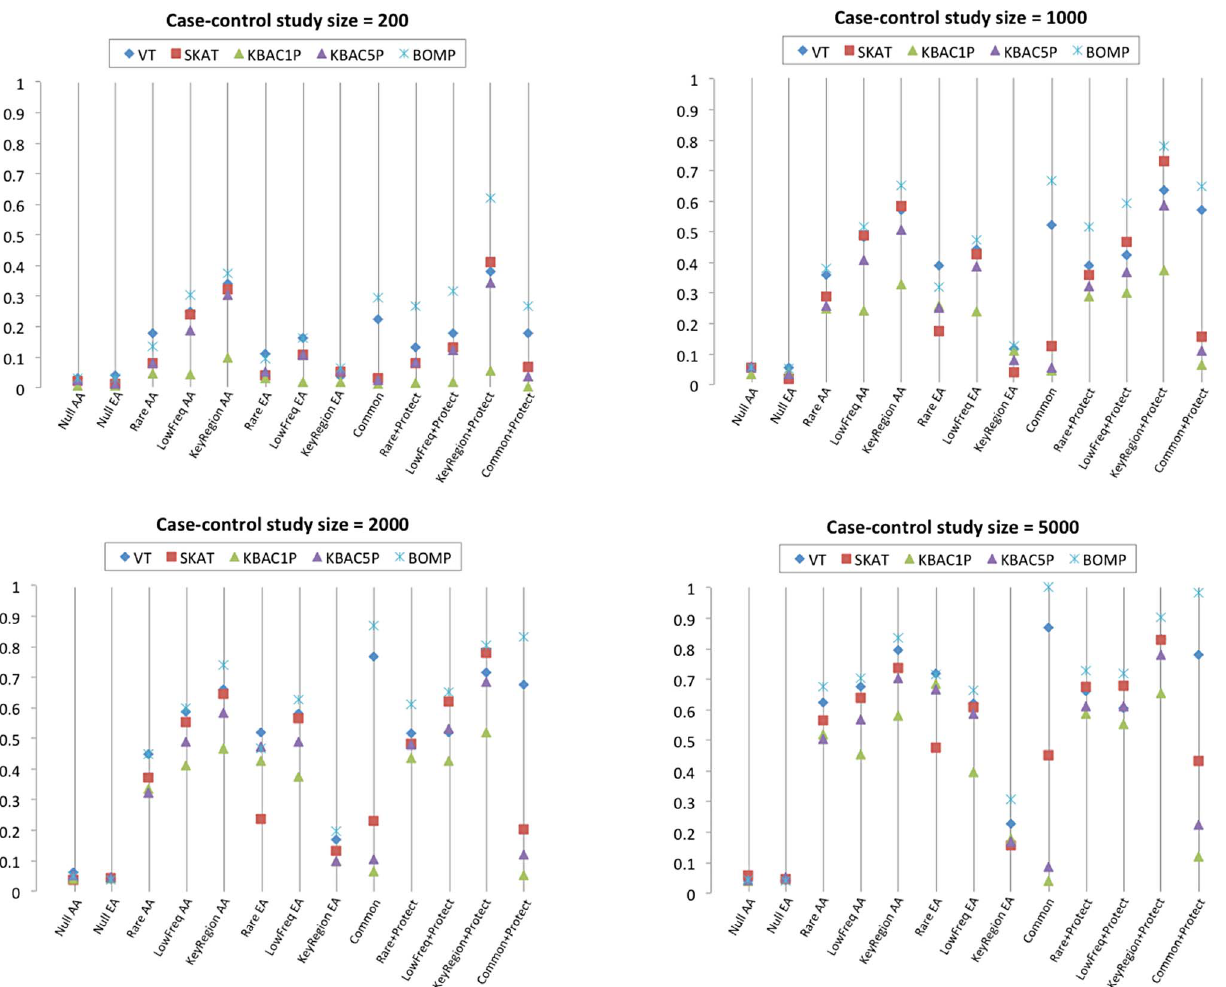
Figure 1. Single gene methods power comparison. Power estimates for BOMP, VT, SKAT, KBAC (KBAC1P=minor allele frequency defined as v 1% , KBAC5P=minor allele frequency defined as v 5% ). Each vertical line represents power estimates for each method, based on 250 simulated case-control studies. AA=the case-control studies were drawn from gene populations generated with an African-American simple bottleneck demographic model. EA=the case-control studies were drawn from gene populations generated with a European-American exponential growth demographic model. The eight variant causality (disease etiology) models are defined in Table 1. Since the European-American demographic model does not account for common or protective variants, etiologies involving common or protective variants were only considered for the African- American demographic model.